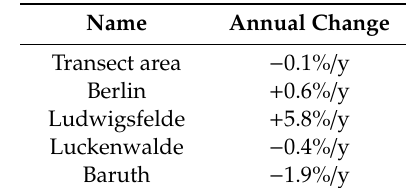
Table A2. Annual change in the average radiance for the areas investigated.